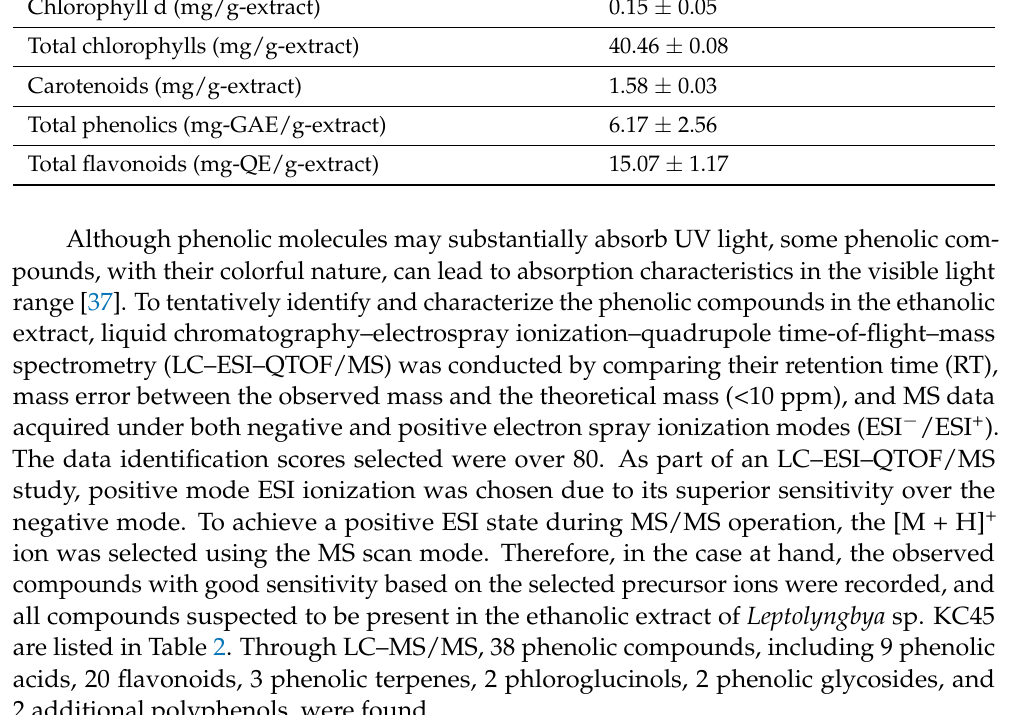
Table 1. Phytochemical composition of the ethanolic extract from cyanobacterium Leptolyngbya sp. KC45. Phytochemicals